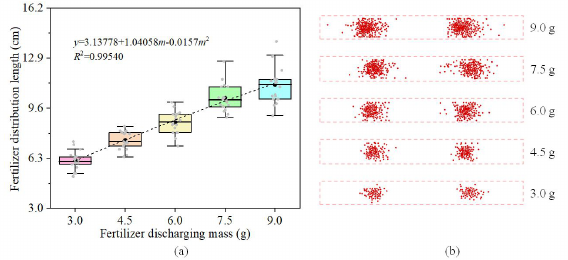
Fig. 7. Variation of the performance of the fertilizer particles with the fertilizer discharging